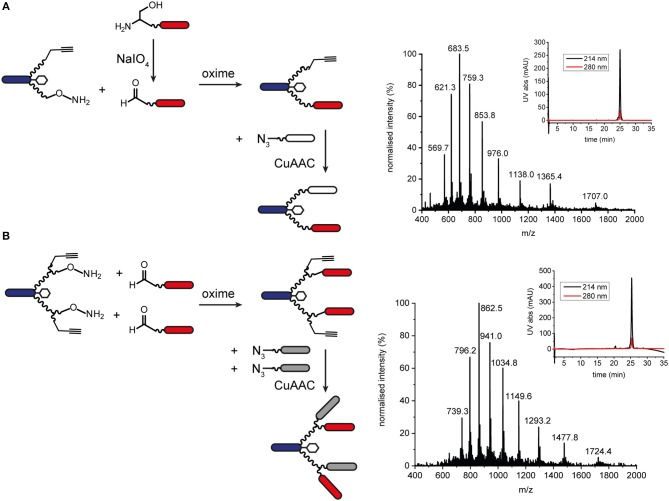
Oxime and CuAAC ligations for modular synthesis of bispecific ISErs. (A) An aldehyde-bearing EphA2-binding peptide was generated from the corresponding N-terminal serine-bearing precursor by oxidation using NaIO4. This binder peptide was ligated to the effector-PEG27 scaffold using oxime ligation and then an azide-bearing integrin α3β1 binding peptide was ligated using CuAAC ligation. MS and analytical HPLC of the bivalent bispecific ISEr product. MWcalc: 6819.9 Da, MWobs: 6818.5 Da. (B) Aldehyde-bearing EphA2 binders were ligated to the effector-PEG27 scaffold using oxime ligation followed by azide-bearing integrin α3β1 binding peptides using CuAAC ligation. MS and analytical HPLC of the tetravalent bispecific ISEr product. MWcalc: 10335.8 Da, MWobs: 10338.5 Da.